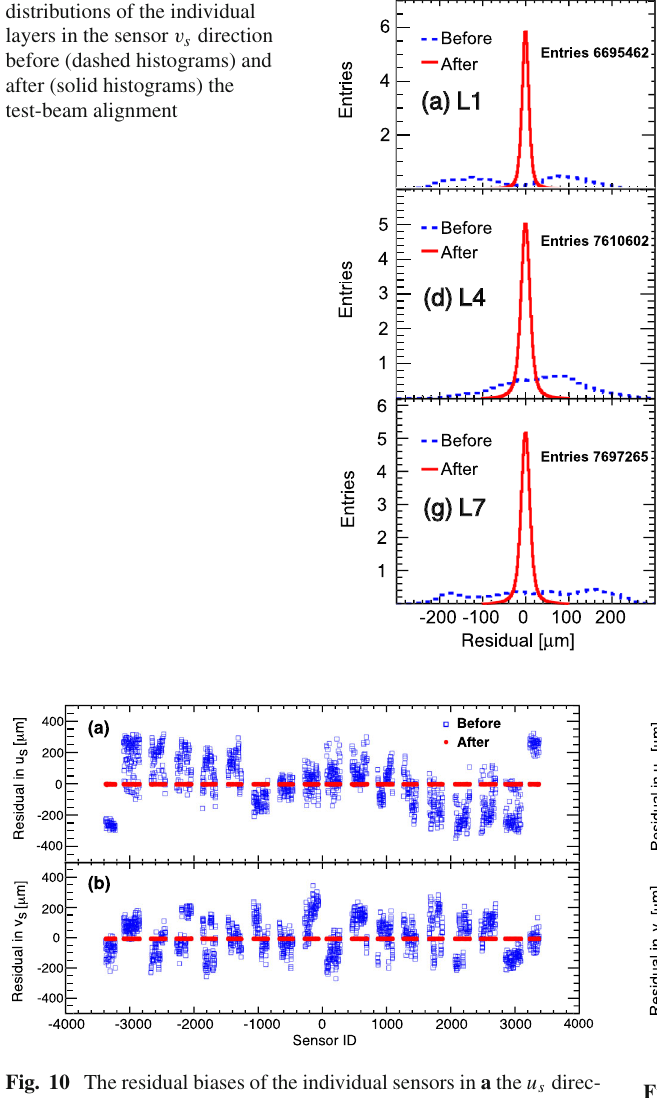
Fig. 9 The residual distributions of the individual layers in the sensor v s direction before (dashed histograms) and after (solid histograms) the test-beam alignment